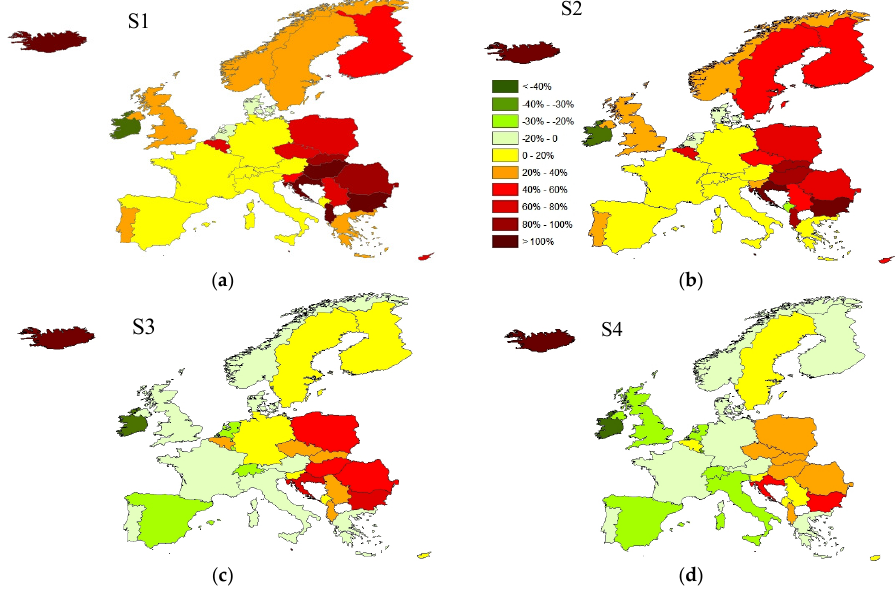
Figure 12. Percentage change in the water footprint (WF) of consumption per capita relative to 2000 in scenarios ( a ) S1, ( b ) S2, ( c ) S3 and ( d ) S4.